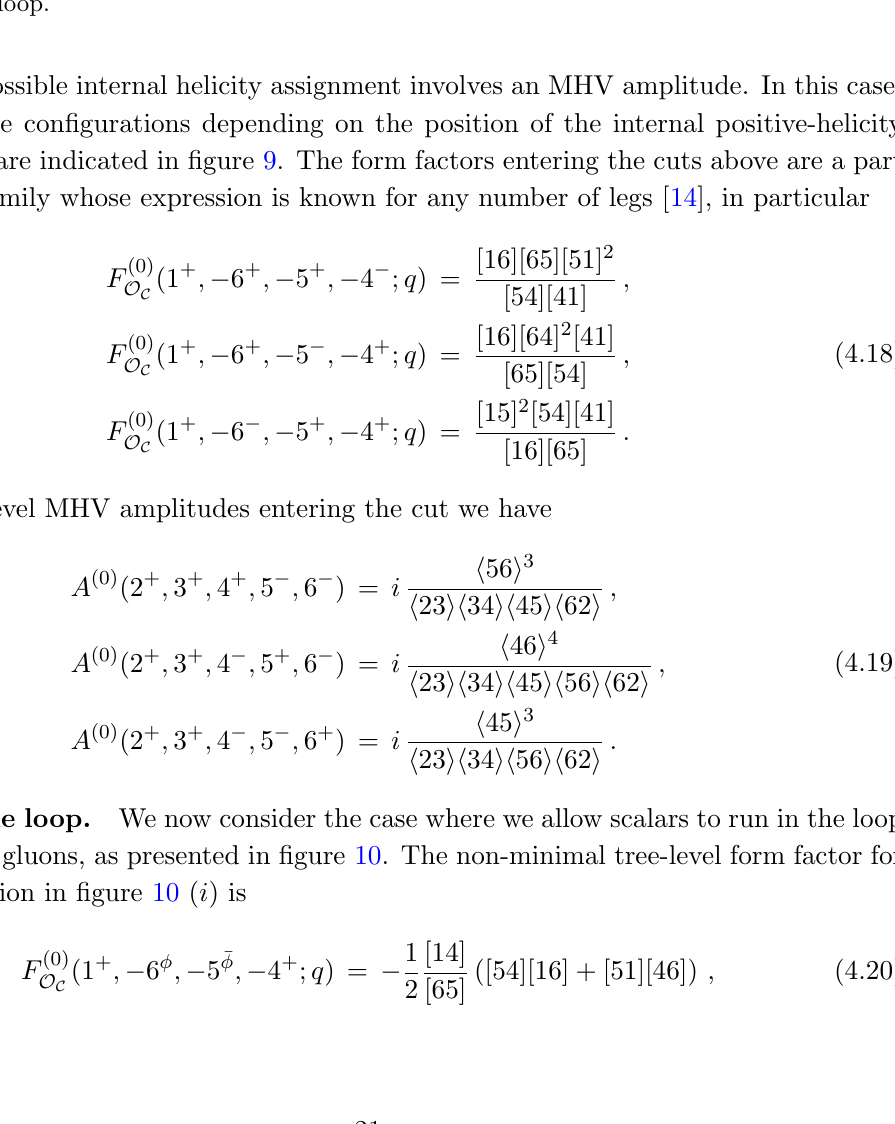
Figure 10 . Triple cut of the two-loop form factor in the s 23 -channel with scalars and a gluon running in the